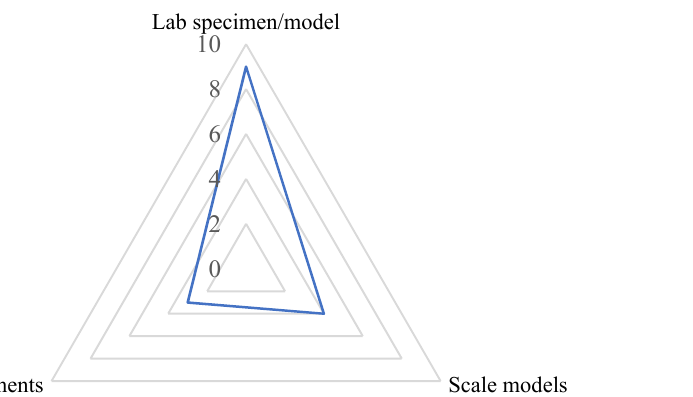
Figure 11. Number of studies carried out using different approaches for low-cost displacement monitoring in